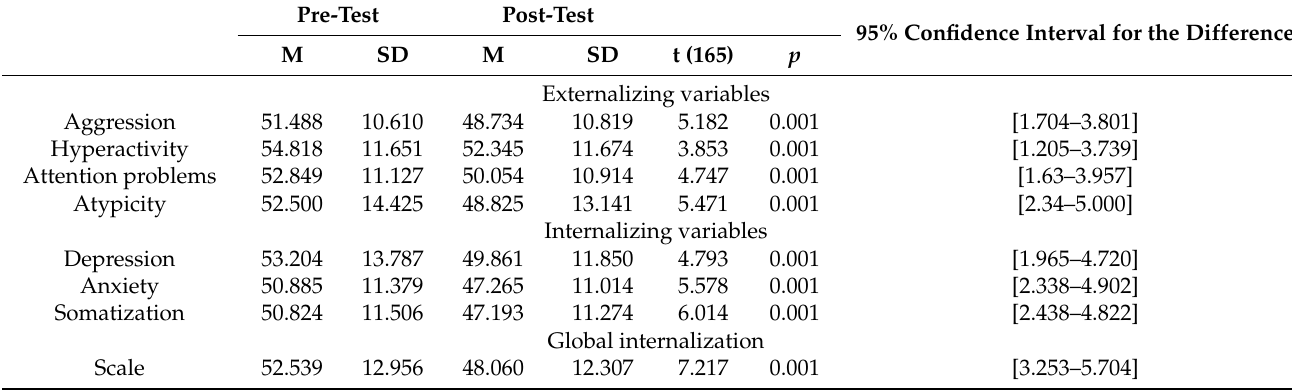
Table 3. Pretest and post-test comparison. Difference in means following the implementation of SFP 11-14. Pre-Test